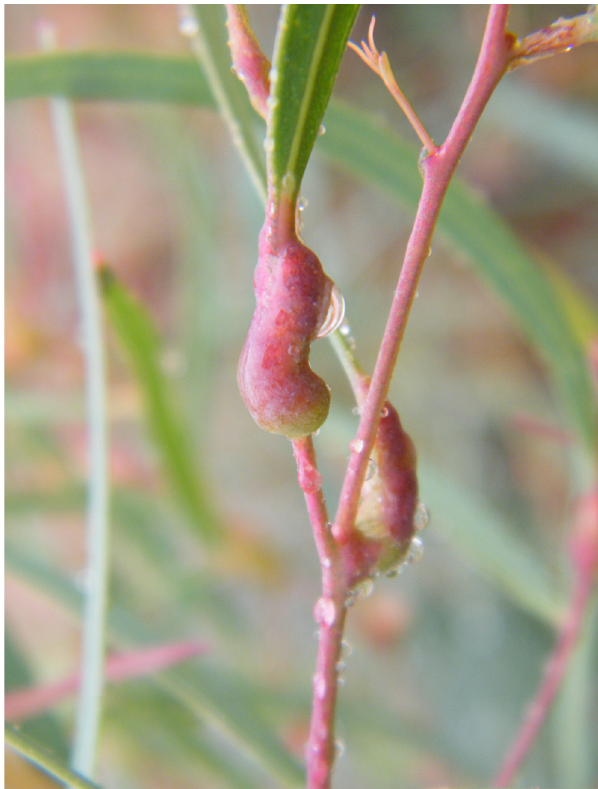
Figure 1. Eucalyptus tereticornis damaged by Leptocybe invasa in